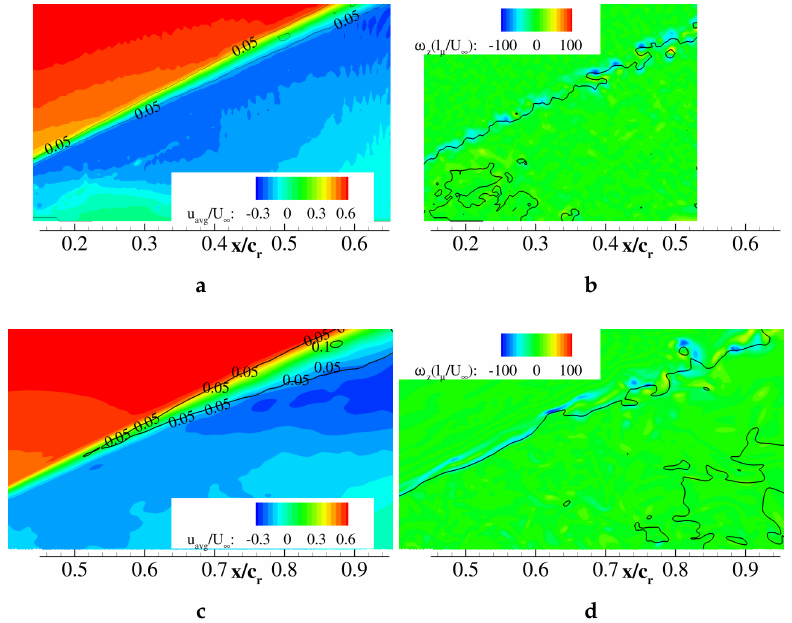
Figure 9. Plane along the vortex core, α = 45 ◦ , Re = 0.5 × 10 6 : ( a ) measured and ( c ) computed averaged axial velocity with k / U 2 ∞ isolines; ( b ) measured and ( d ) computed instantaneous in-plane vorticity with isolines representing u = 0. DES views ( c , d ) shifted by 0.3 in the relative chordwise and spanwise